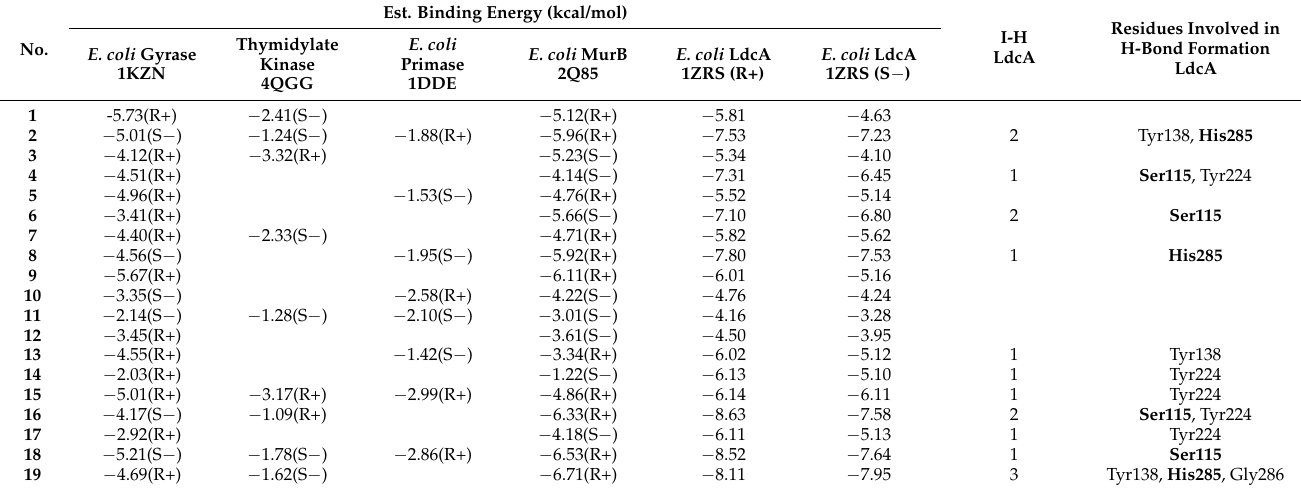
Table 9. Molecular docking estimated free energy of binding to antibacterial